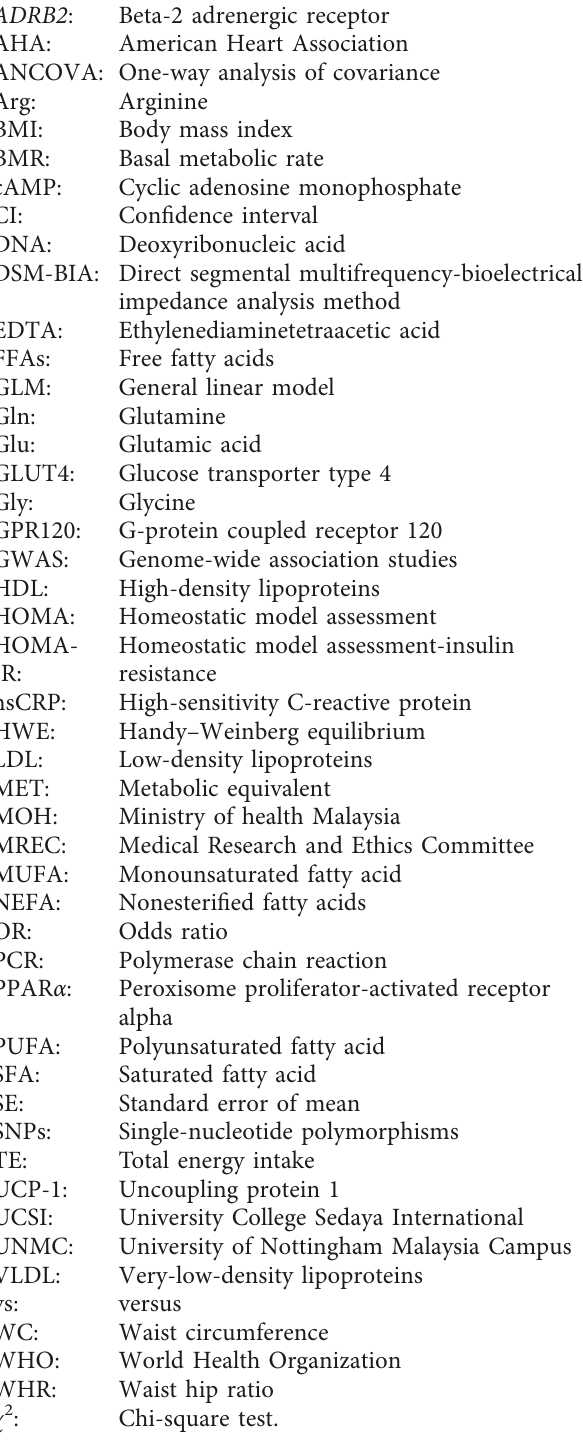
Supplementary Table 1: physical activity and lifestyle of study participants. ( Supplementary Materials